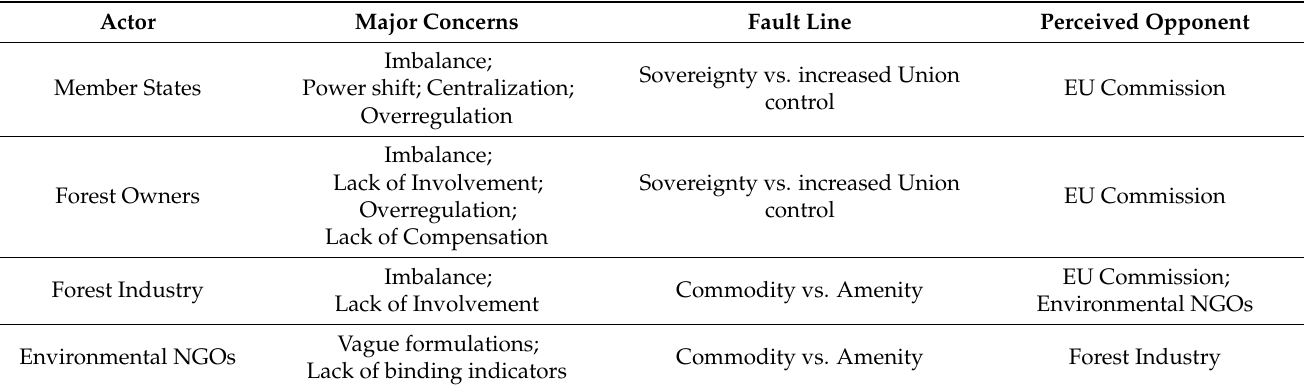
Table 1. Fault lines in the New EU Forest Strategy for